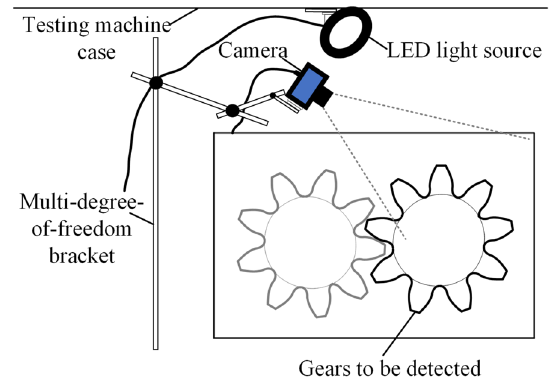
Figure 6 Schematic of the visual detection platform